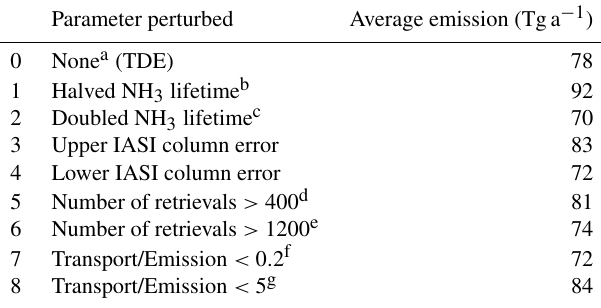
Table 1. Uncertainty and sensitivity analyses of top-down NH 3 emissions. Annual averaged NH 3 emissions are summed over global land areas for